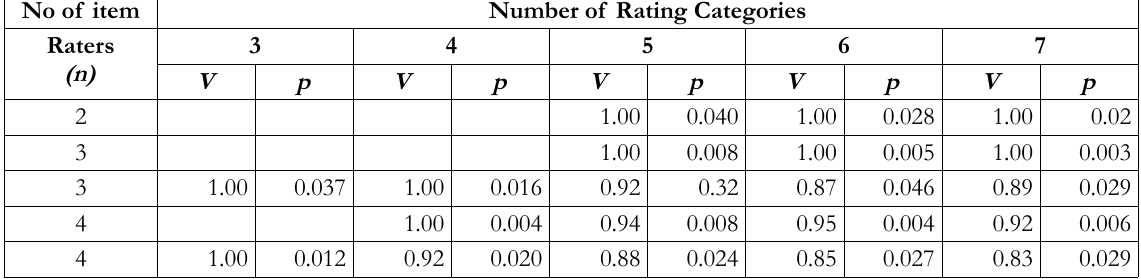
Table 2. Aiken Minimum Validation